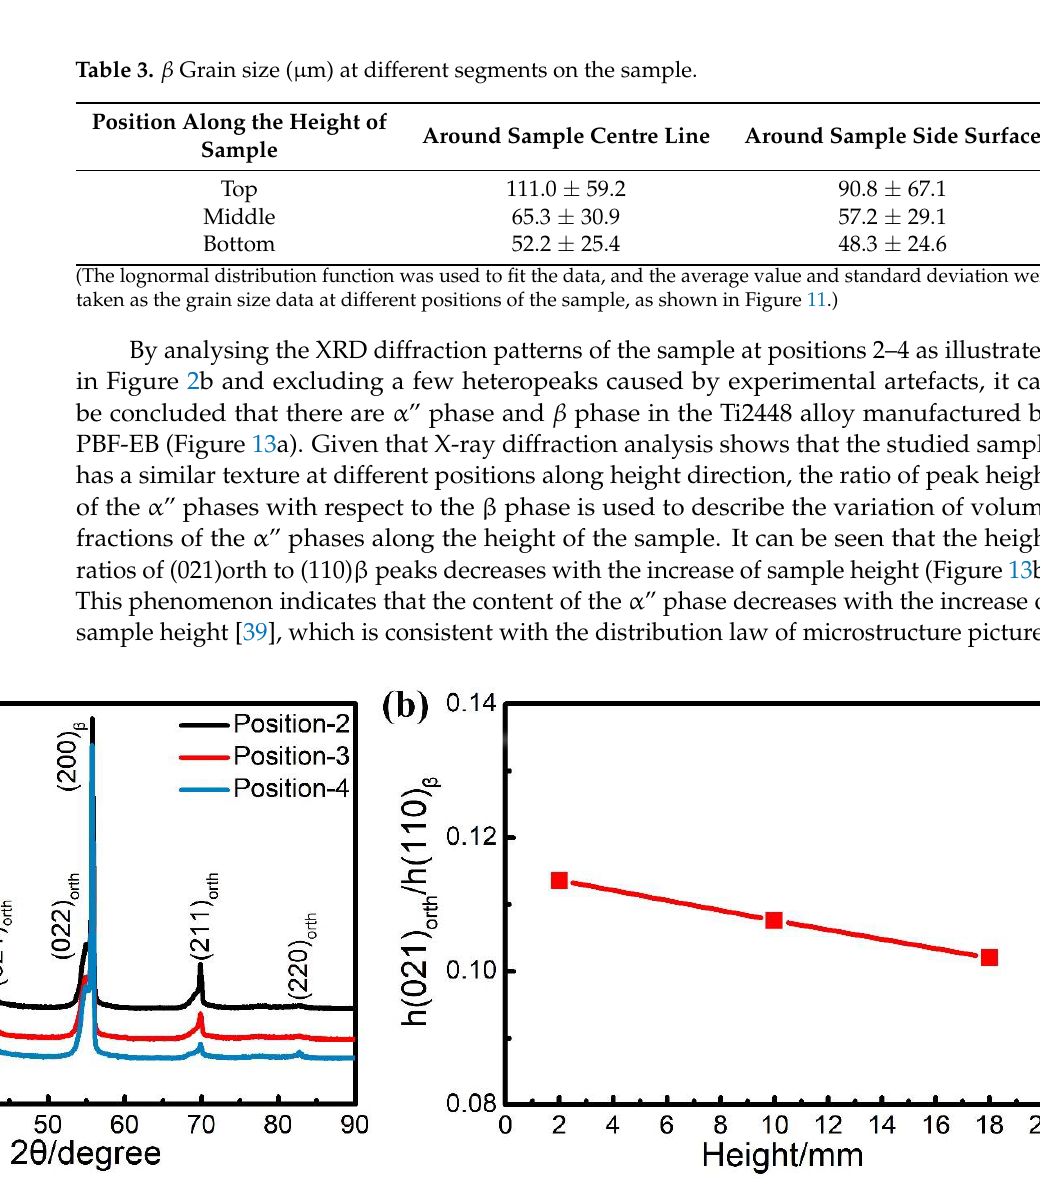
Table 3. β Grain size ( µ m) at different segments on the sample.